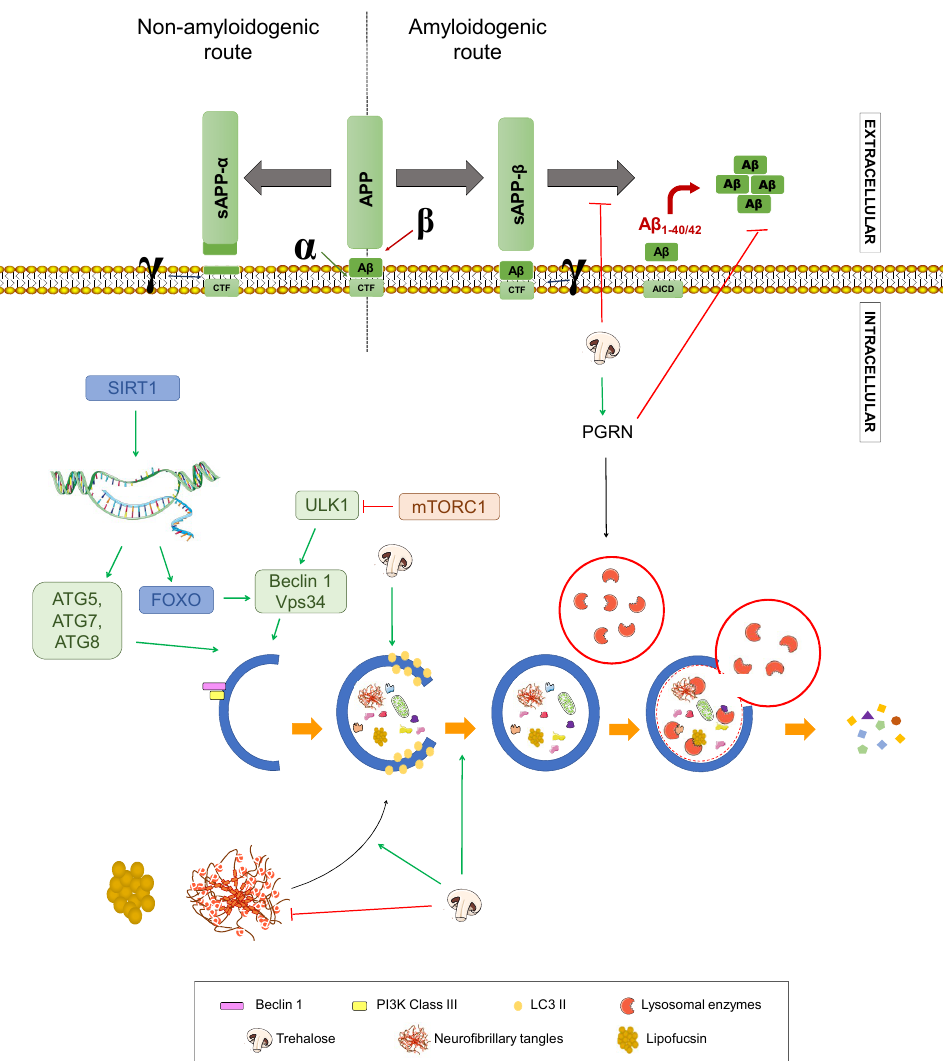
Figure 8. Effect of trehalose on Alzheimer’s disease. Summary of the processes by which trehalose may modulate Alzheimer’s disease. APP: amyloid-beta precursor protein. sAPP α : soluble α -APP. sAPP β : soluble β -APP. CTF: carboxy-terminal fragment. AICD: APP intracellular domain. SIRT1: Sirtuin 1. ATG: Autophagy-related gen. ULK1: unc-51 like autophagy activating kinase 1. FOXO: Forkhead box class “O” proteins. VPS34: Vacuolar protein sorting 34. mTORC1: mammalian target of rapamycin complex 1. Green arrows represent activation. Red truncated arrows represent